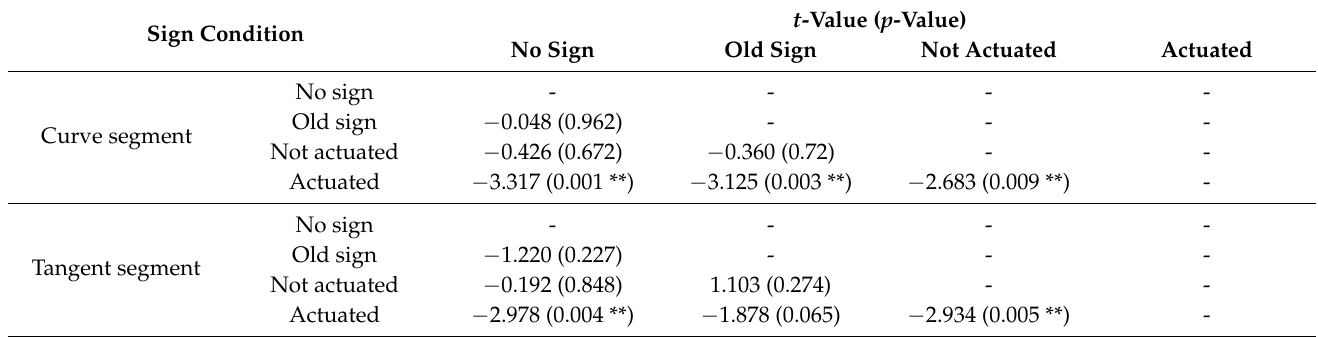
Table 3. Comparison between each of the signs in terms of speed deceleration values in two cases.